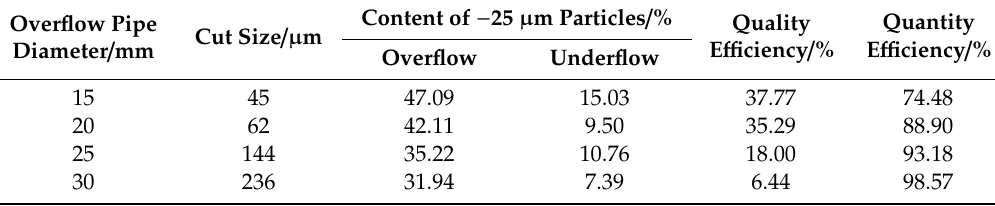
Table 2. The classification performance.